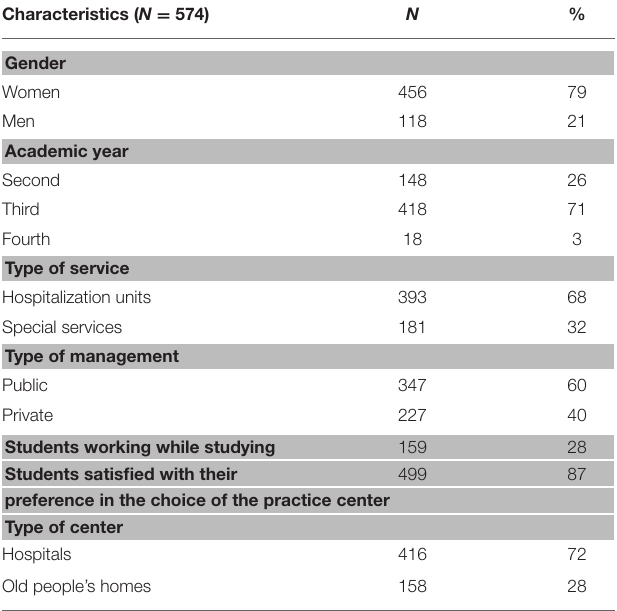
TABLE 1 | Characteristics of the